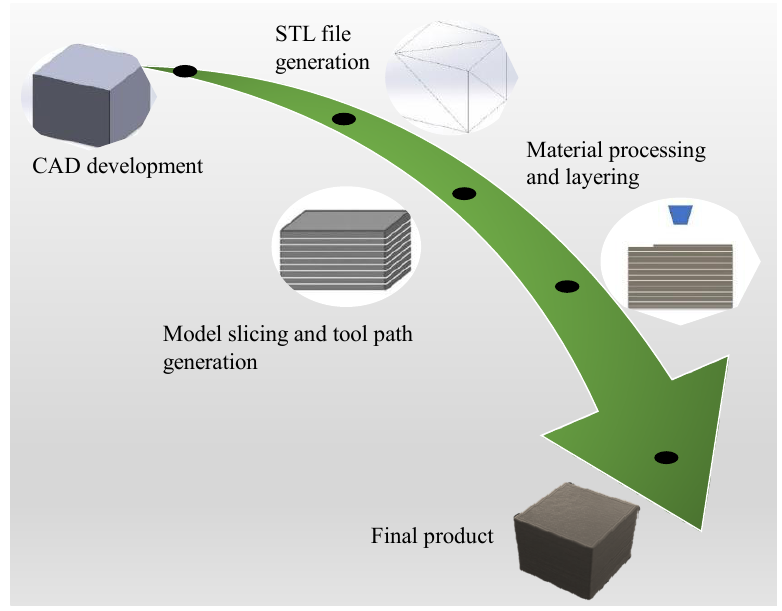
Figure 2. The workflow of the 3D printing process.